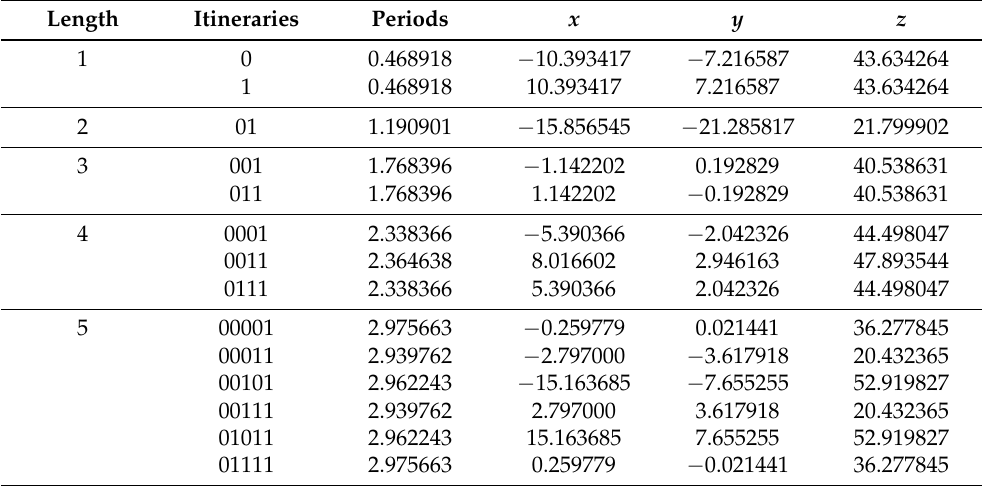
Figure 13. Two simplest periodic orbits as basic building blocks in system (2) for parameters ( a , b , c , d ) = ( 35,3,35,10 ) : ( a ) cycle 0 and ( b ) cycle 1. Table 3. Unstable cycles embedded in hidden chaotic attractor of system (2) up to topological length 5 for ( a , b , c , d ) = ( 35,3,35,10 )